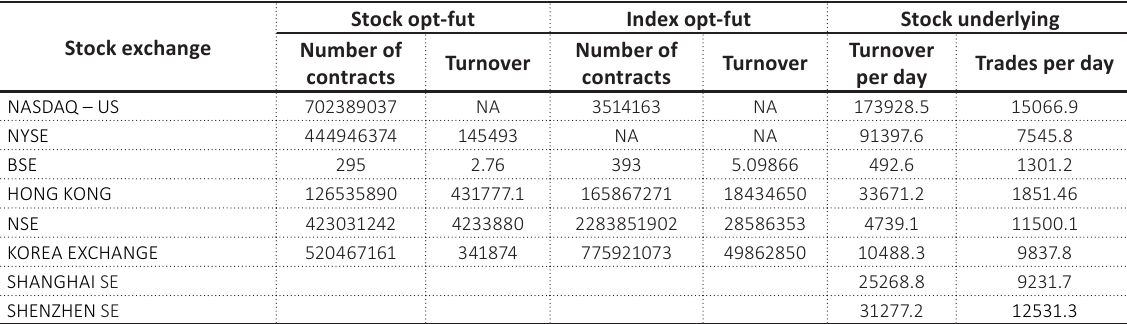
Table 4. Derivative business